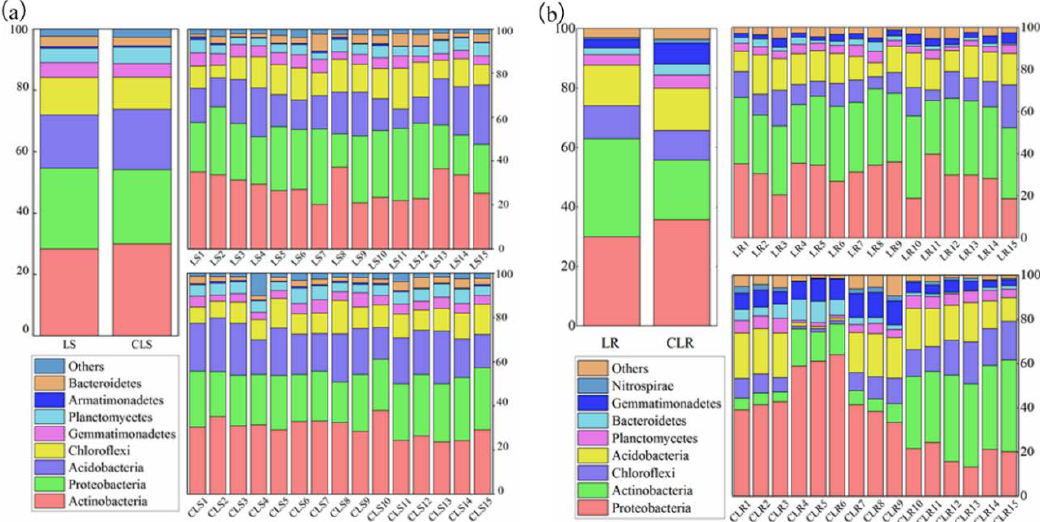
Figure 3. Bar diagram to represent the analysis at phylum level in mining subsidence area ( a ) and vegetation rehabilitation area ( b